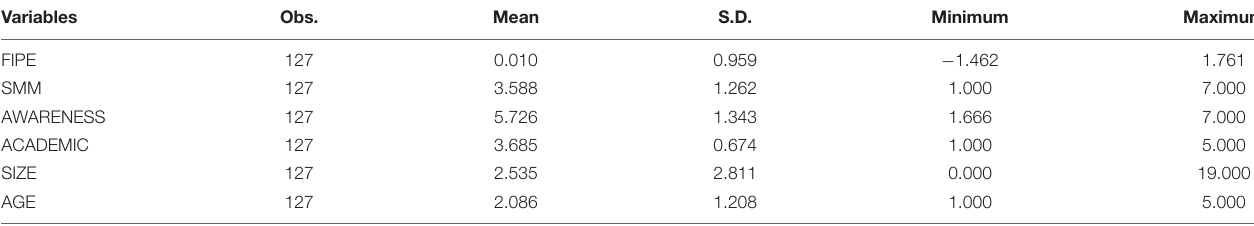
TABLE 1 | Descriptive statistics.